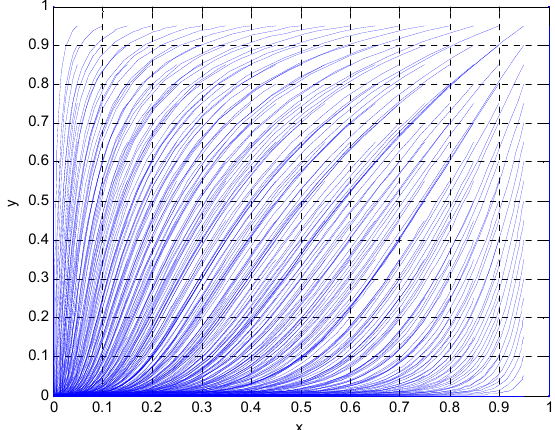
Figure 2. Initial state of government regulatory departments and vaccine manufacturers.